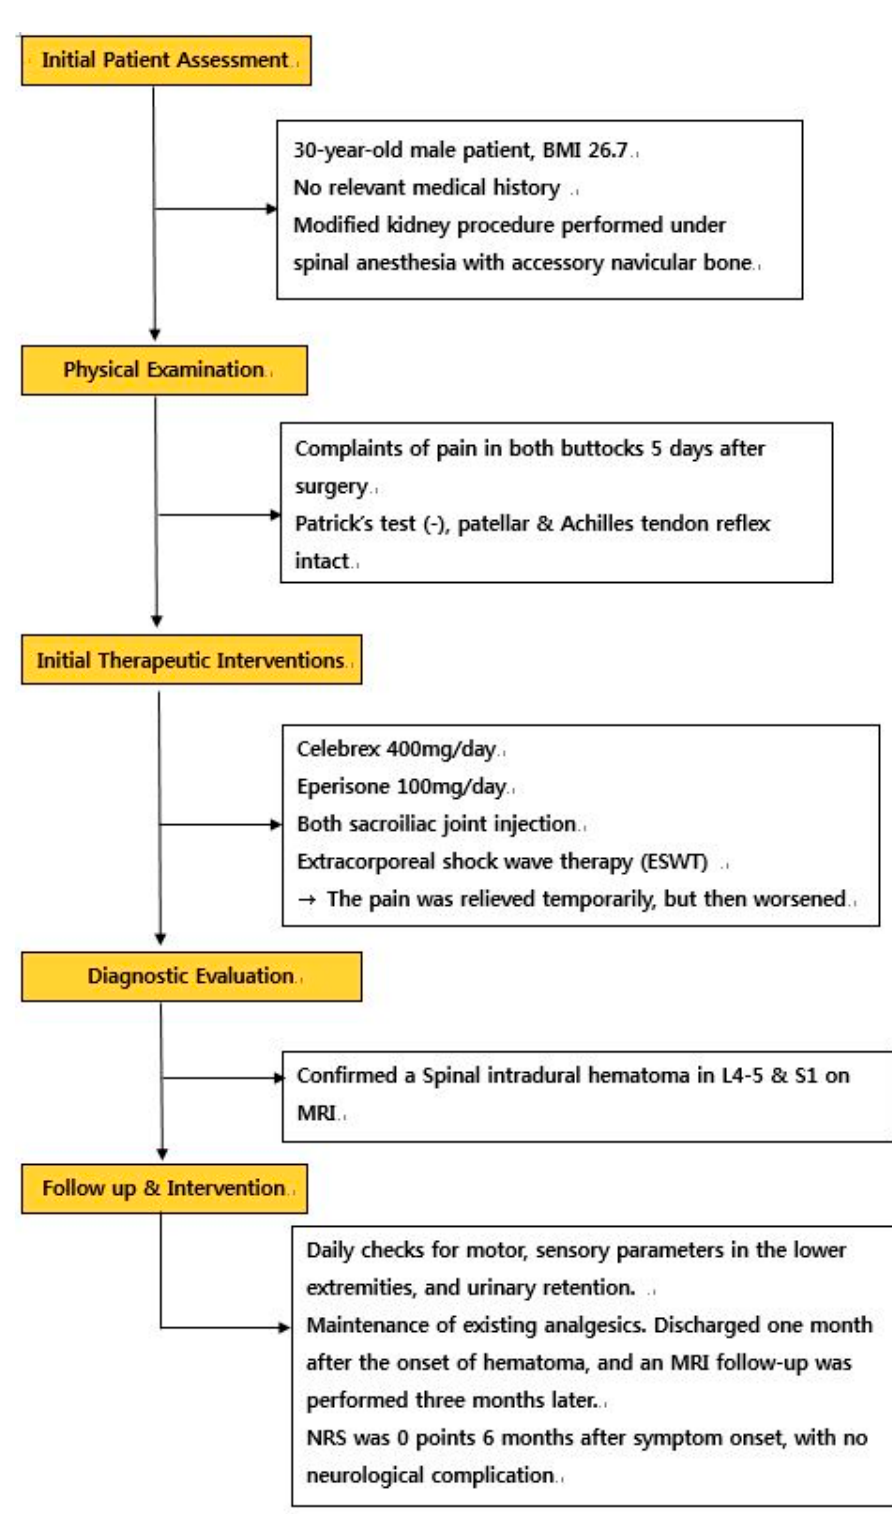
Figure 5. Flow Figure 5. Flow diagram.